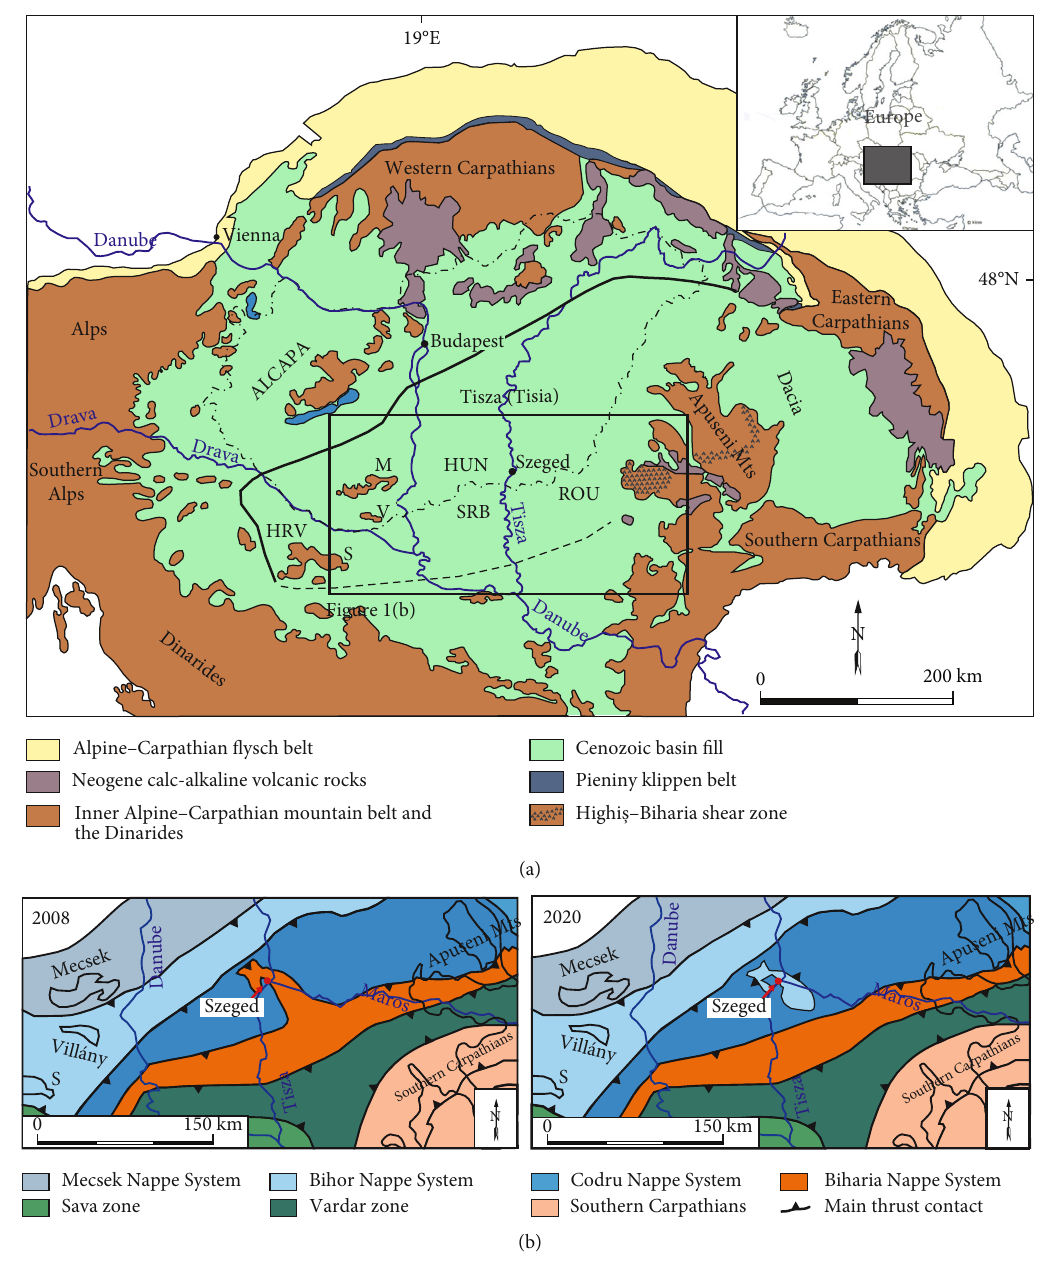
Figure 1: Geological framework. (a) The Alpine – Carpathian – Pannonian area [3, 14 – 16, 18]. Abbreviations: ALCAPA: Alpine – West Carpathian – Pannonian block; M: Mecsek Hills; S: Slavonian Mts; V: Villány Hills; HRV: Croatia; HUN: Hungary; ROU: Romania; and SRB: Serbia. (b) Main Alpine tectonic units of the study area according to a previous interpretation [12] and modi fi ed boundaries of the Alpine units based on a new concept [17]. Note that the fragments of the Biharia Nappe System have not been proven in Hungary based on the traditional Hungarian tectonic studies and maps [14 – 16]. Abbreviation: S: Slavonian